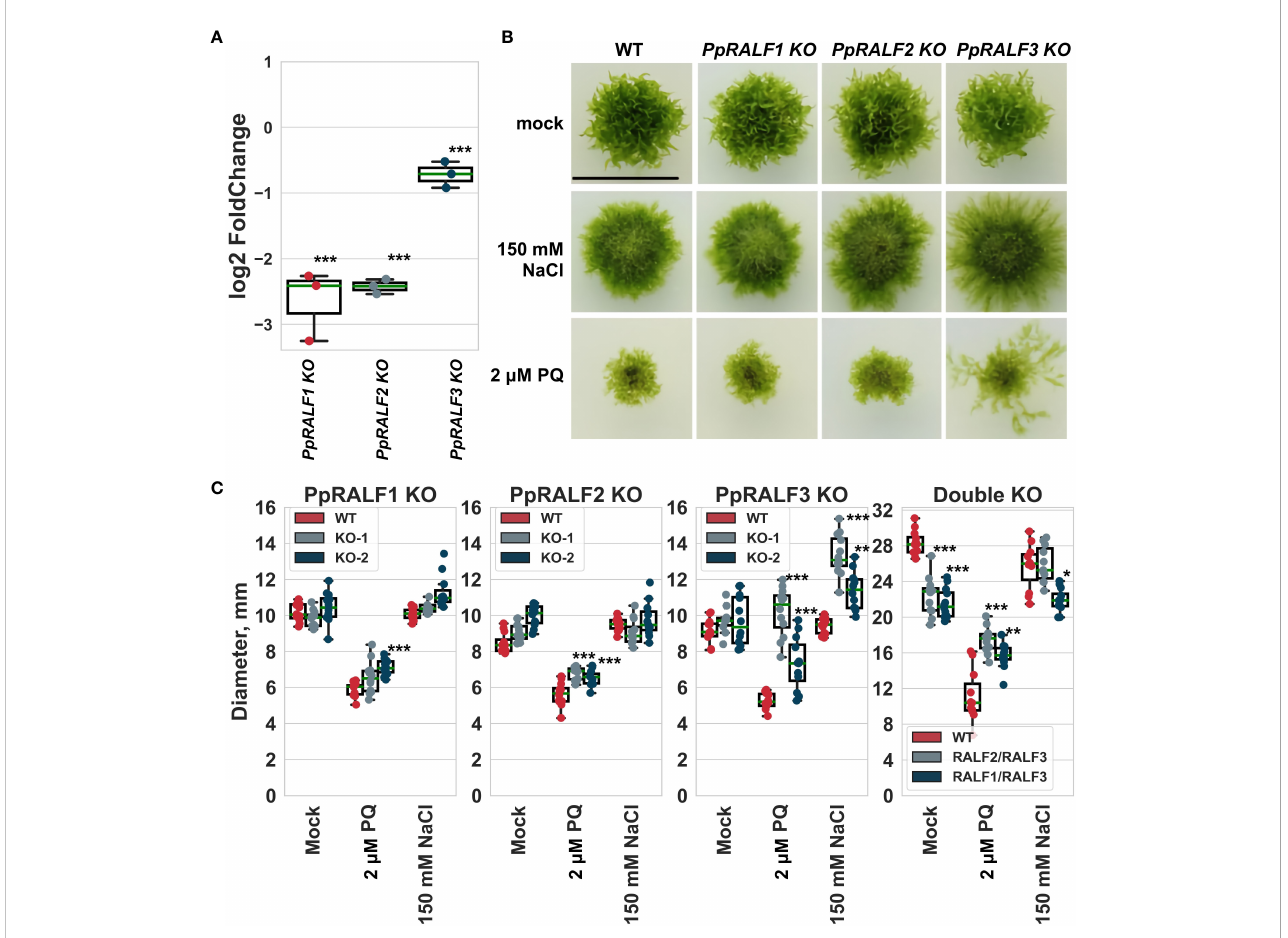
FIGURE 3 (A) The results of quantitative reverse transcription PCR (RT-qPCR) analysis of the transcriptional level of PpRALFs under hydrogen peroxide treatment for 2 hours. Analysis of variance and Tukey ’ s HSD post hoc tests were performed *** P < 0.001. Log2FoldChanges represent the logarithmic fold change of the PpRALF genes transcription in treated samples relative to control samples, normalized to a reference gene (2- DD CT values); (B) Phenotype of 30-d- old plants of wild-type and the knockout lines grown on medium supplemented with 150 mM NaCl or 2 m M paraquat. Scale bar: 10 mm; (C) The measured diameter of moss plants grown on medium supplemented with 150 mM NaCl or 2 m M paraquat. Analysis of variance and Tukey ’ s HSD post hoc tests were performed *** P < 0.001, ** P<0.01, * P <0.05 (comparison to the corresponding wild-type